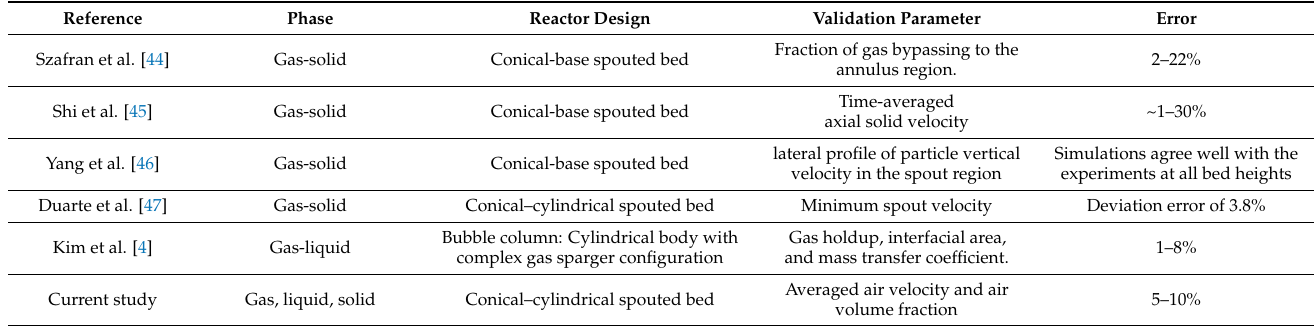
Table 7. Summary of some CFD validated results studied based on 2-dimentional axisymmetric assumption.